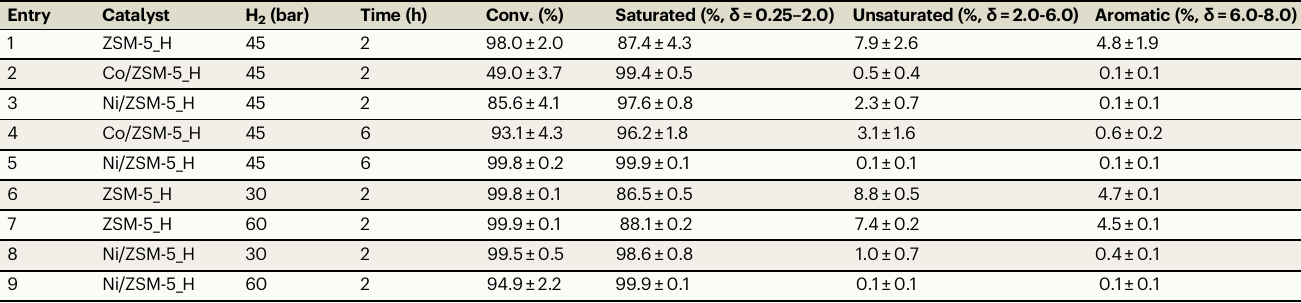
Table 3 | Degrees of saturation of the liquid products obtained from the deconstruction of n- hexadecane under hydrogen Entry Catalyst H 2 (bar) Time